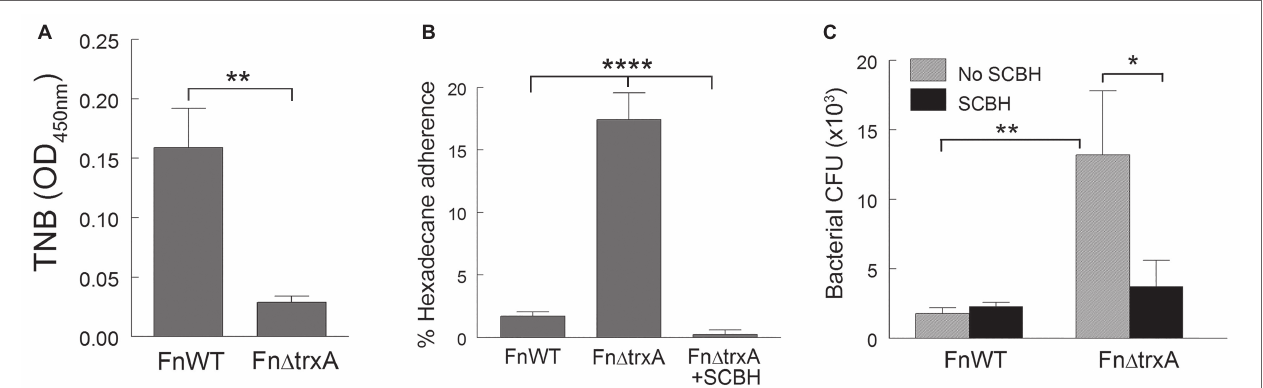
FIGURE 4 | Thioredoxin modulates cell surface hydrophobicity in Francisella novicida . (A) Reduction of disulfide bonds by F. novicida wild type (FnWT) and Fn Δ trxA measured through reduction of DTNB to TNB. (B) Adherence of Fn and Fn Δ trxA to n-hexadecane with and without sodium cyanoborohydride (SCBH) treatment. (C) Recovered CFU/well of bacteria, with or without SCBH treatment, following phagocytosis by J774 cells. Statistical differences were determined by one-way (A,B) and two-way (C) ANOVA with Holm-Sidak correction for multiple comparisons (**** p < 0.0001; ** p < 0.01; * p <